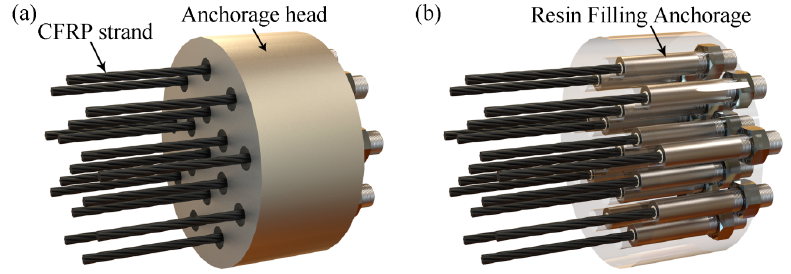
Figure 12. Multiple Resin Filling Anchorage System, ( a ) full view and ( b ) transparent view.